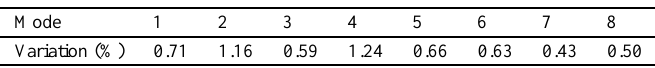
Table 3 Variations of the natural frequencies due to welding